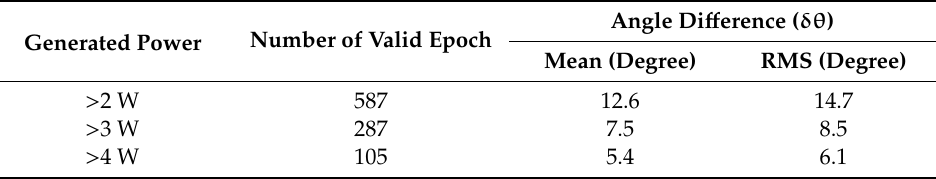
Table 3. Attitude estimation performance with different power generation ranges.